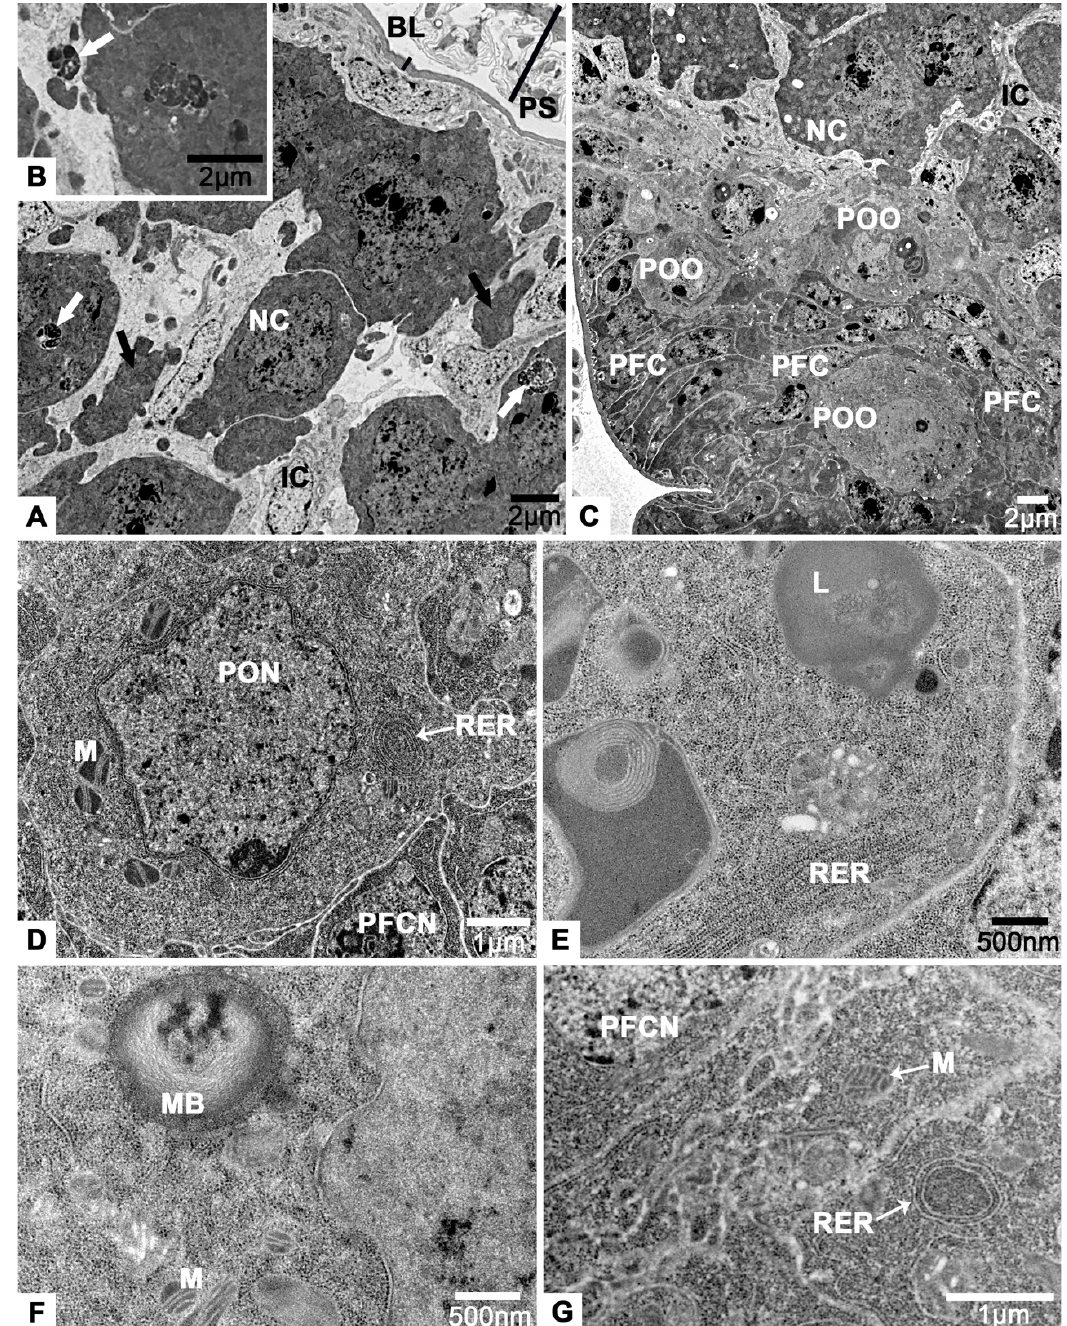
Figure 6. The posterior region of tropharium of T. klimeschi on sixteenth day post-eclosion. ( A ) The nurse cell clusters and interstitial cells. The remains of nurse cell cytoplasm are present in the interstitial cells (black arrows). There are many phagosomes (white arrows) filled with highly condensed material in the nurse cells. ( B ) Phagosomes in the interstitial cells (white arrow). ( C ) The preoocytes and prefollicular cells. ( D – F ) The preoocyte and its cytoplasmic contents. ( G ) The cytoplasmic contents of prefollicular cell. Nurse cell (NC); interstitial cell (IC); peritoneal sheath (PS); basal lamina (BL); preoocyte (POO); prefollicular cell (PFC); nucleus of a preoocyte (PON); nucleus of a prefollicular cell (PFCN); lysosomes (L); mitochondria (M); rough endoplasmic reticulum (RER); and multilamellar body (MB).